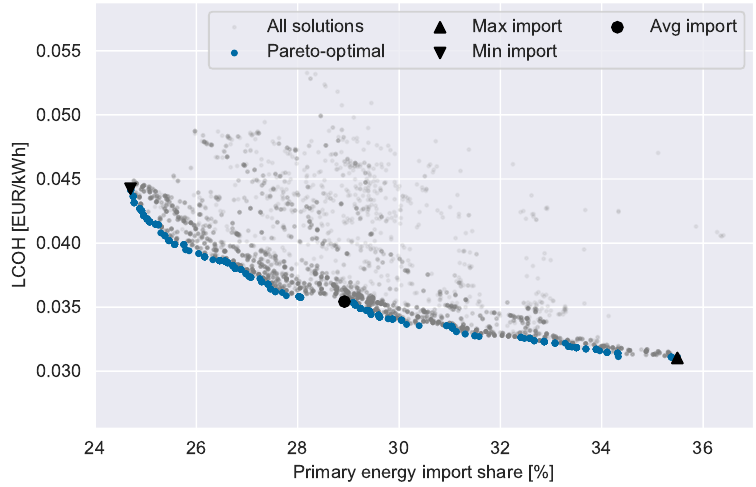
Figure 3. Scatter plot of all genetic design algorithm solutions for the reference design